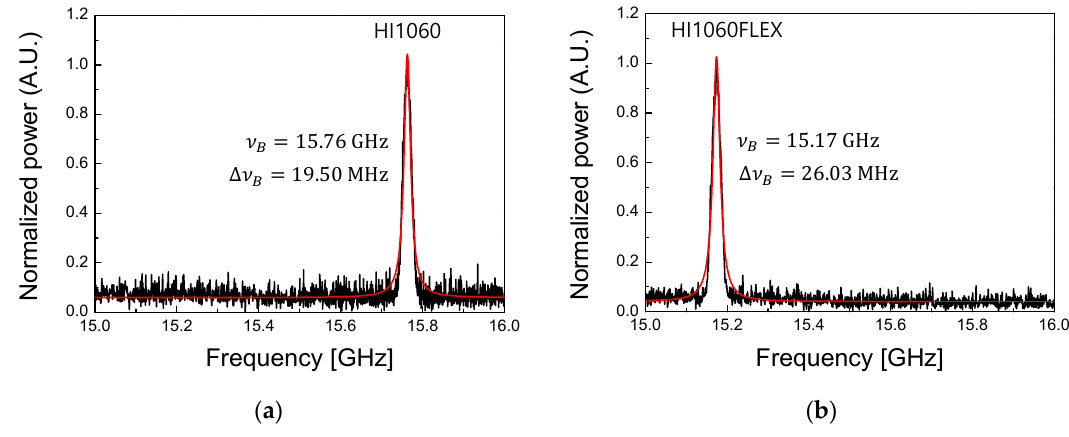
Figure 2. Stimulated Brillouin scattering (SBS) spectra measured by the experimental setup in Figure 1. The two 1060 nm SMFs, ( a ) HI1060 and ( b ) HI1060FLEX, had the equal length of 500 m and the measurements were made at the room temperature, the red curves are the Lorentzian fitting. Here the signal power incident to FUT was about 55 mW at λ = 1064 nm.